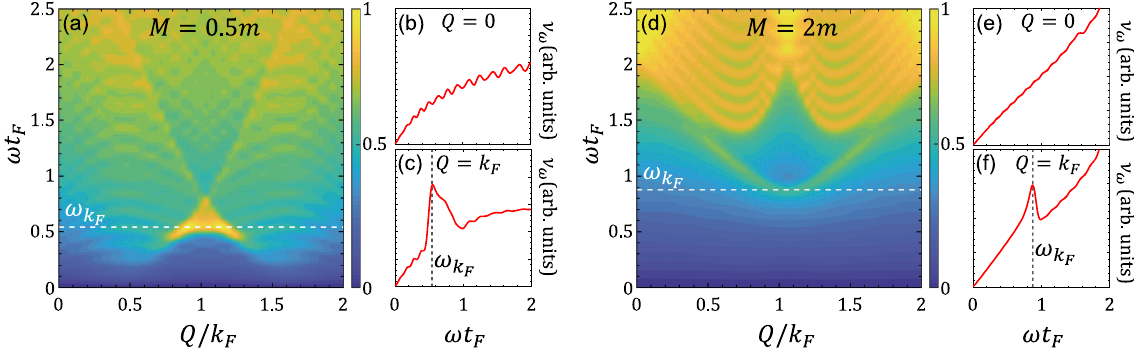
FIG. 9. The DOS of collective excitations as a function of frequency ω and total momentum Q for M ¼ 0 . 5 m (a) – (c) and for M ¼ 2 m (d) – (f). For M ¼ 0 . 5 m , we observe a rather dispersive peak; at Q ¼ k , the DOS is notably broad (c). This is because the magnon branch F approaches plasmon for small impurity masses so that their dispersions are parallel to each other over a wide range of momenta near k is sharp (f), but its spectral weight is relatively weak. Parameters are the same as in Fig. For M ¼ 2 m , the peak at Q ¼ k F